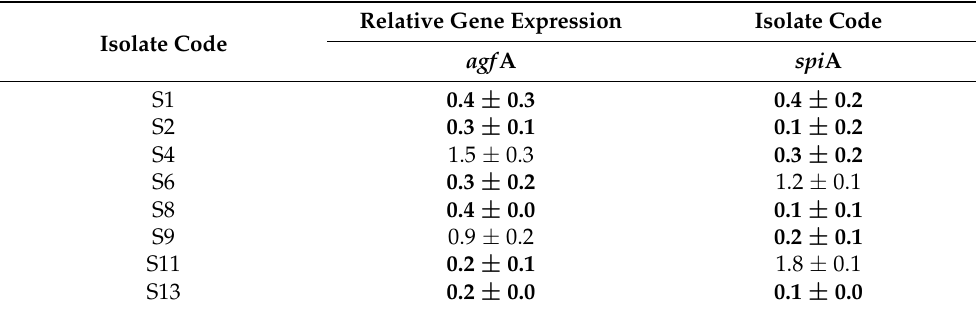
Table 4. The relative expression (mean ± SD) of the tested genes related to biofilm formation in S. enterica isolates after treatment with